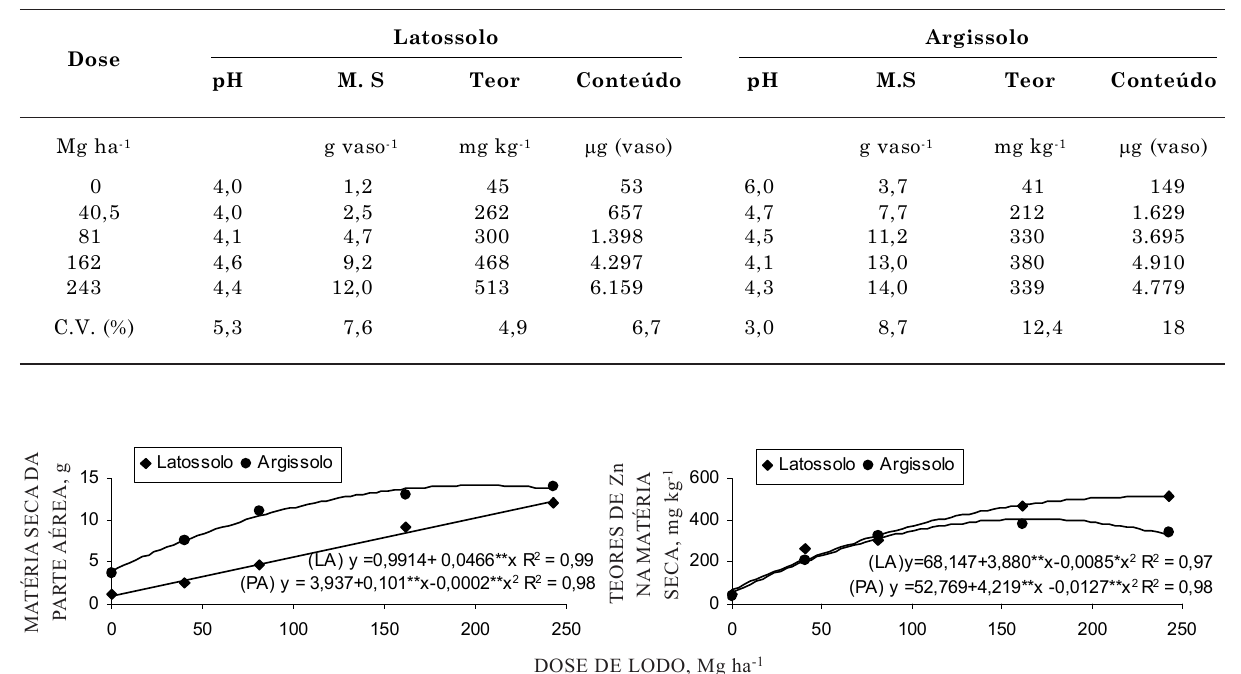
Figura 1. Matéria seca da parte aérea, teores de Zn de acordo com doses de lodo de esgoto em dois solos de